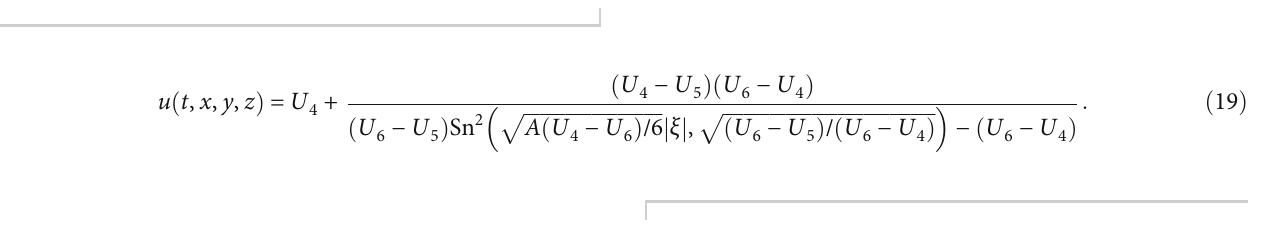
ffiffiffiffiffiffiffiffiffiffiffiffiffiffiffiffiffiffiffiffiffiffiffiffiffiffiffi